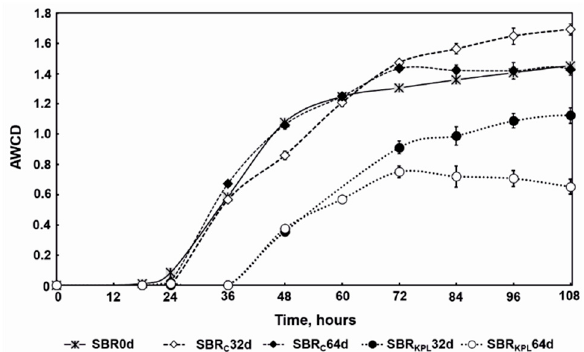
Figure 6. Comparison of average well color development (AWCD) of metabolized substrates in Biolog ® EcoPlate TM (Biolog, Inc., Hayward, CA, USA) by the AS microorganisms at the beginning (0d) and after 32 and 64 days of wastewater treatment in the SBR C and SBR KPL